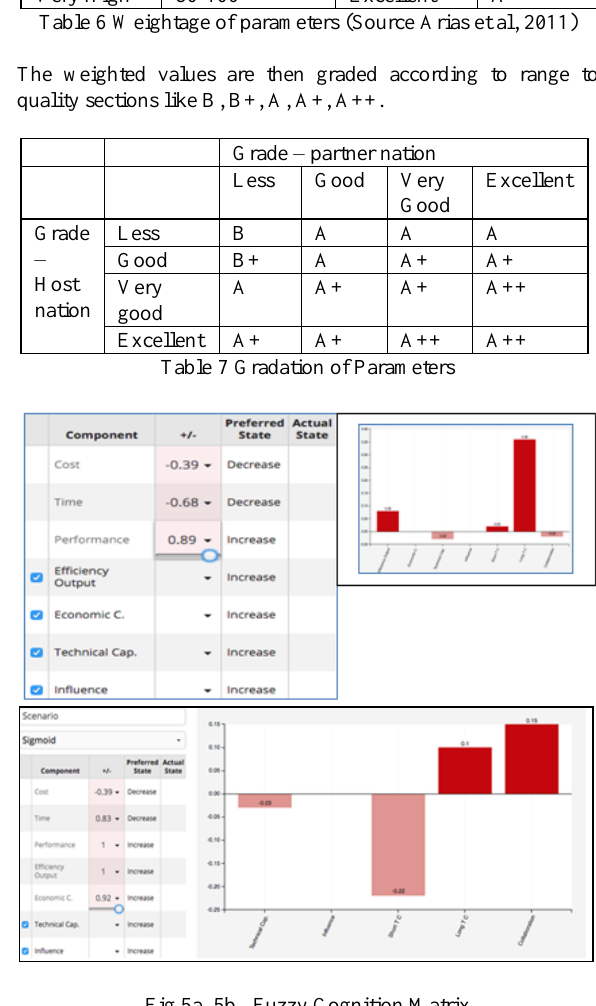
Fig 5a, 5b. Fuzzy Cognition